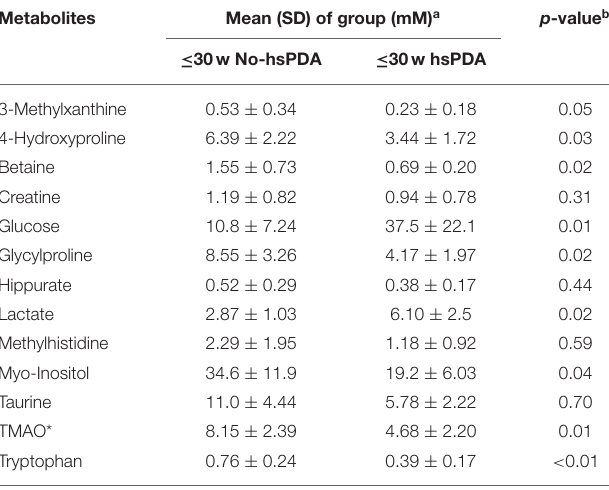
TABLE 5 | Discriminant metabolites for OPLS-DA